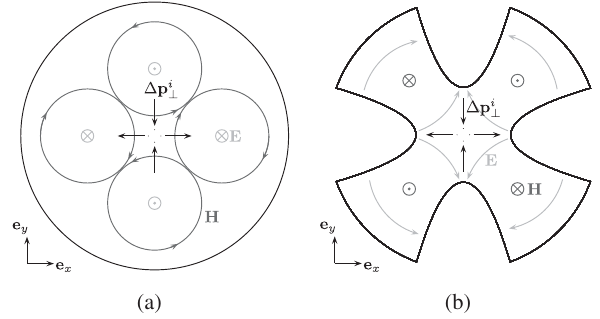
FIG. 1. Cross section of quadrupolar field profiles providing the transverse kick to the particle according to (1). The force directions corresponds to a negative charge q . (a) Pillbox with TM-type mode. (b) Four-Vane-Cavity with TE-type